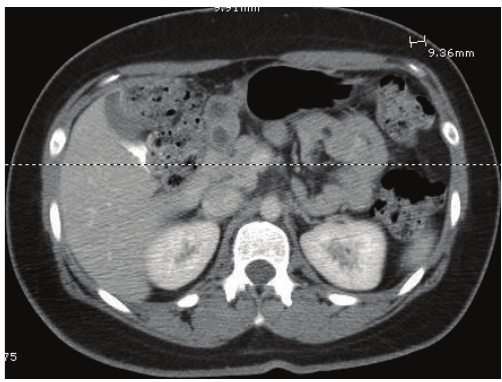
Figure 4: CT scan demonstrated four cystic lesions in the medial wall of distal antrum and pylorus measuring approximately one cm each, suggestive of duplication cysts.